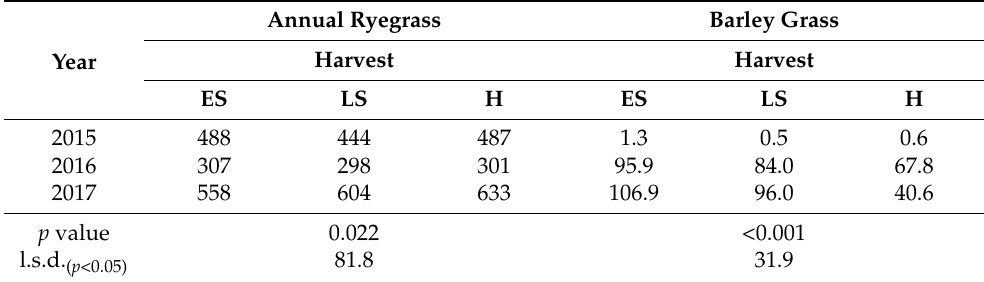
Table 6. Annual ryegrass and barley grass content (g/kg) of forage crops grown in 2015, 2016 and 2017, and forage harvested as early silage (ES), late silage (LS) or hay (H) at Wagga Wagga NSW (year ×